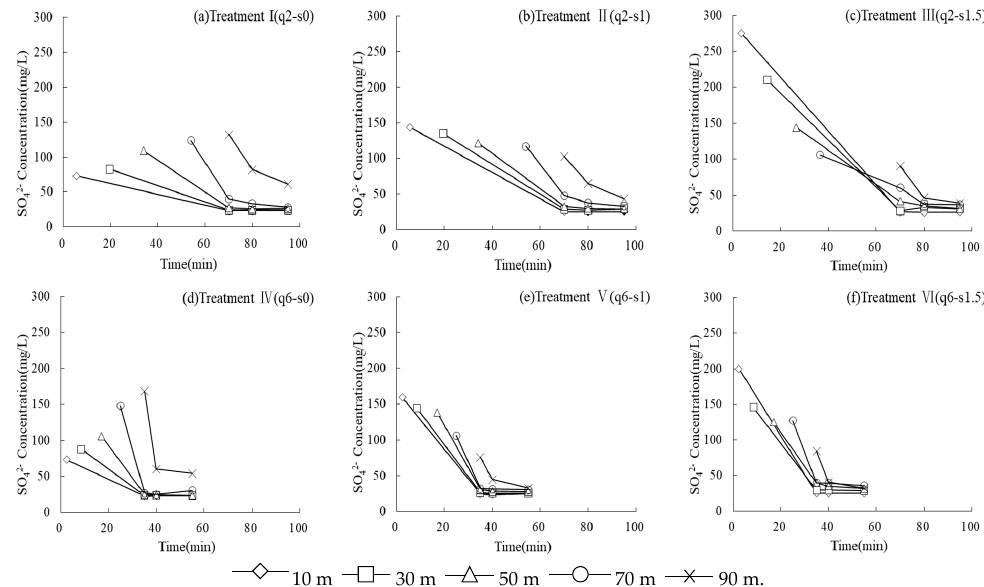
− in the surface water flow over time at 4